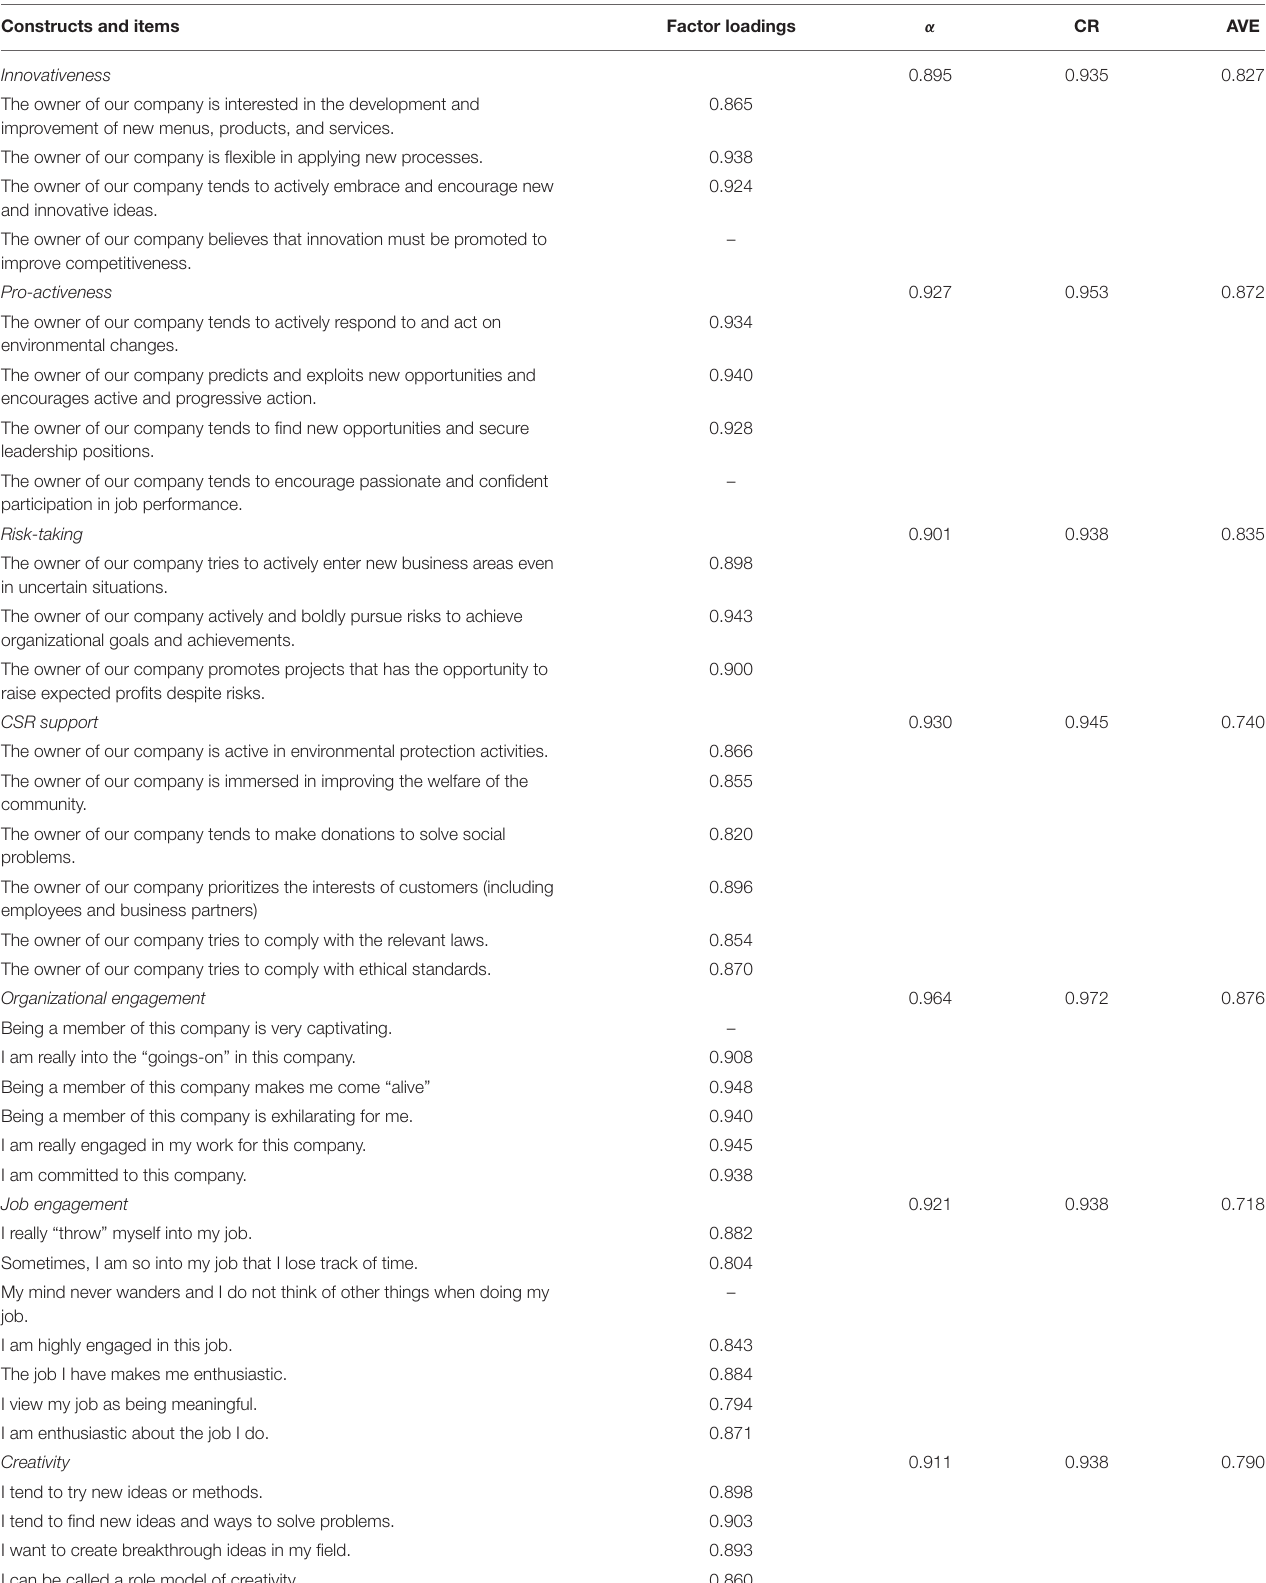
TABLE 2 | Measurement model. Constructs and